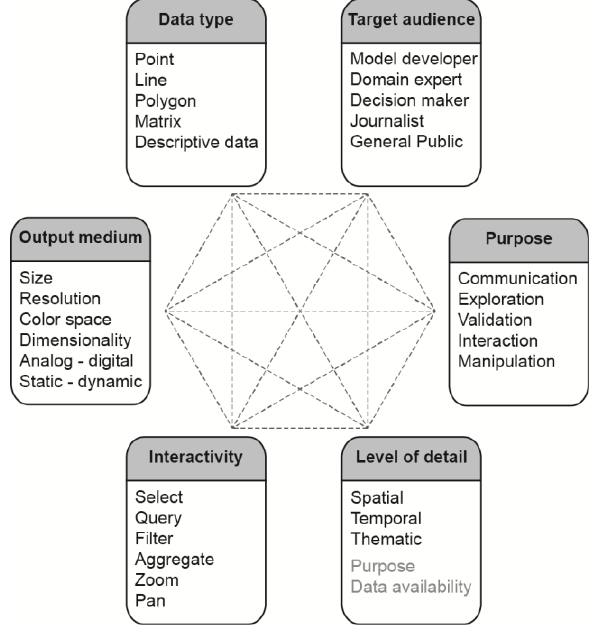
Figure 3. Interdependent dimensions that are relevant for the choice of appropriate (geo-) visualizations of transport data.